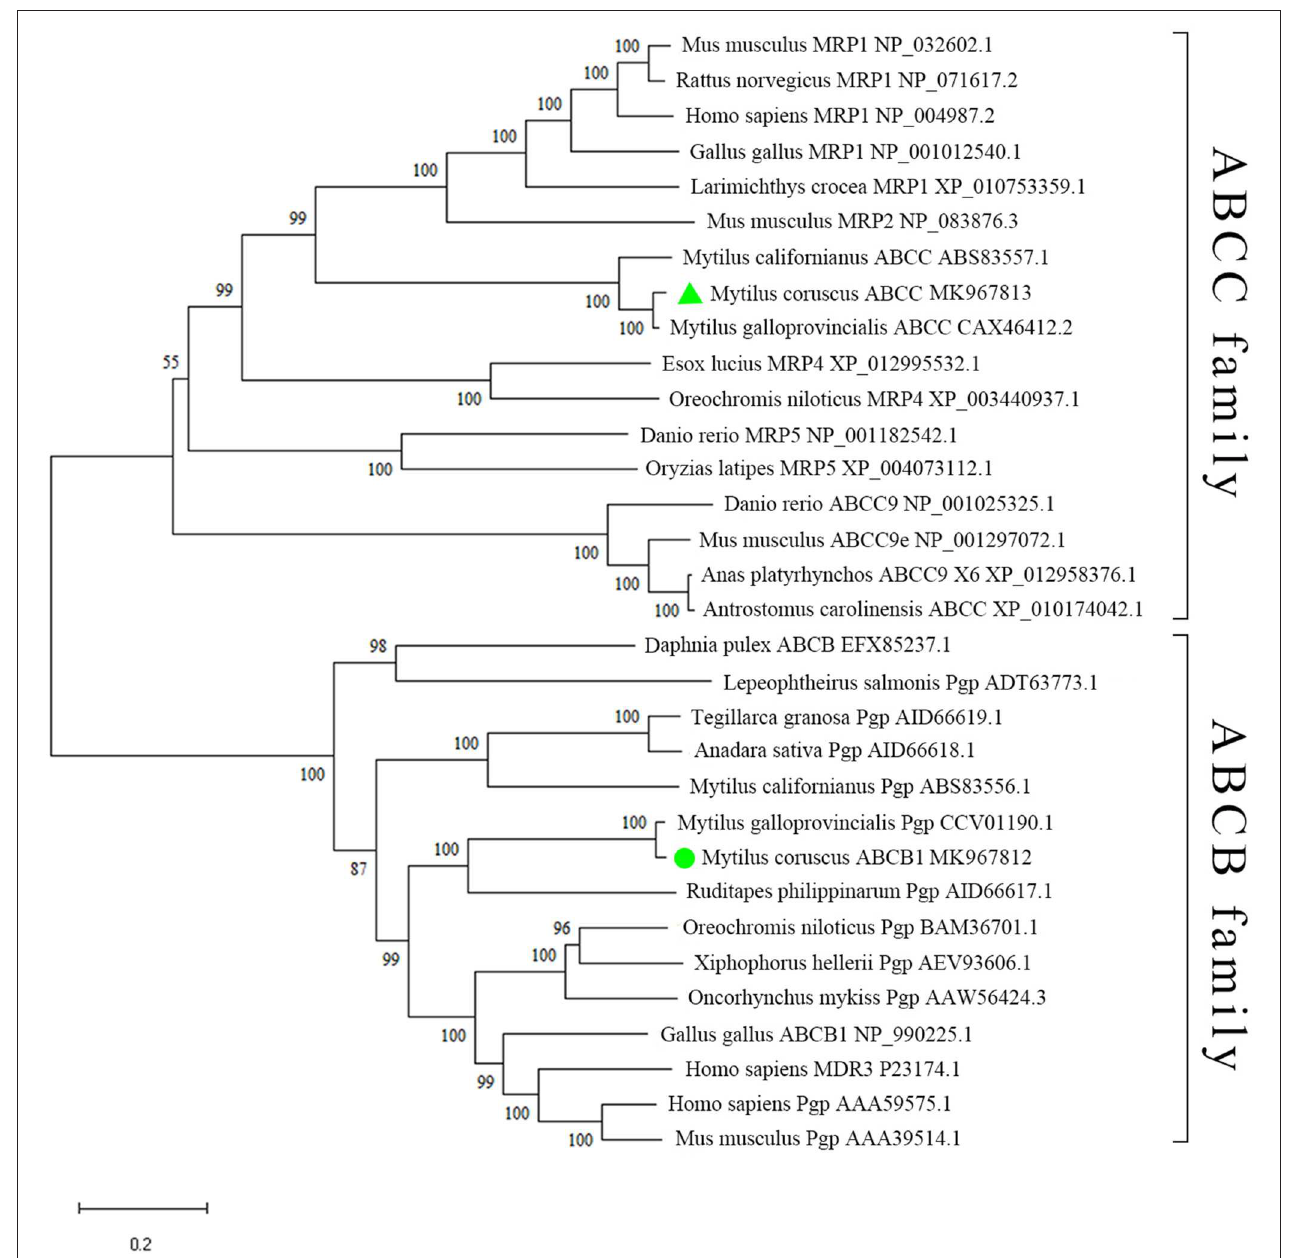
FIGURE 3 | Phylogenetic analysis of Mco ABCB1 and Mco ABCC. Mco ABCB1 and Mco ABCC are denoted by green circle and green triangle, respectively. The species included in our phylogenetic tree are obtained from Genbank database, and their accession numbers are displayed on the tree (For interpretation of the references to color in this figure legend, the reader is referred to the web version of this